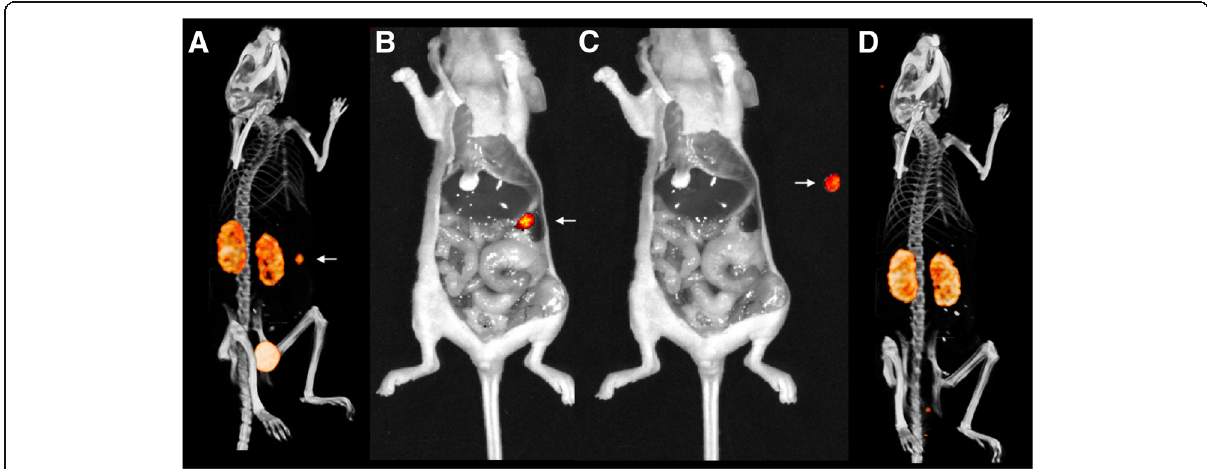
Fig. 4 Near-infrared fluorescence images ( b , c ) and microSPECT/CT images ( a , d ) of a mouse with a CEA-expressing intraperitoneal LS174T tumor (arrow) 2 h after administration of 111 In-RDC018. Pre-resection, the tumor can be clearly localized using microSPECT/CT ( a , white arrow) and near- infrared fluorescence imaging ( b , white arrow). Subsequently, after euthanization, the tumor was resected with fluorescence image guidance ( c , white arrow). Finally, a post-resection microSPECT/CT was acquired ( d ) confirming the complete resection of the tumor nodule. The radio signal of the renal clearance of 111 In-RDC018 can also be observed in a and